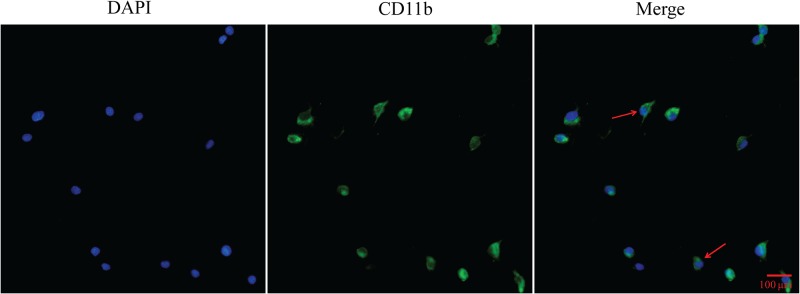
Primary cultured microglia purity identification by immunofluorescence.Blue signal indicates nuclear staining with DAPI; green signal represents CD11b staining with FITC; arrows represent microglia with typical morphology.